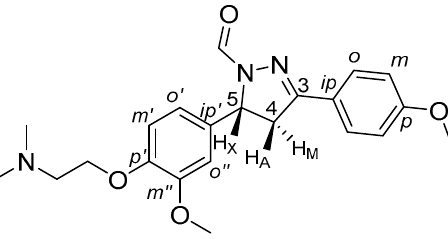
Figure 1. Structure and numerical assignment of compound 5d .